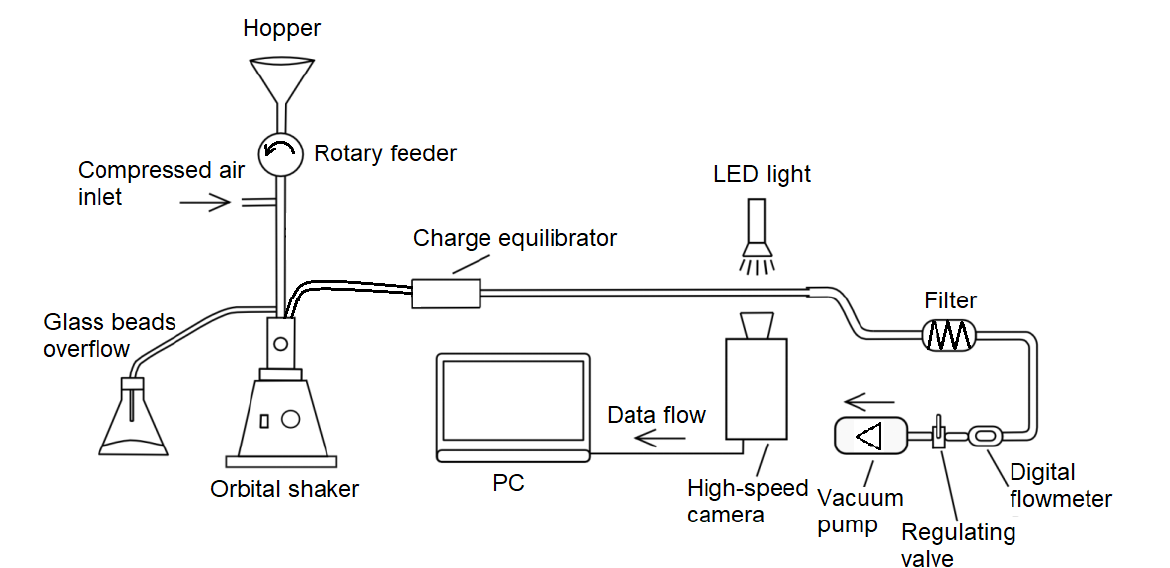
Fig. 1. A scheme of the experimental rig for visualization of flow of glass fibres in a replica of the human